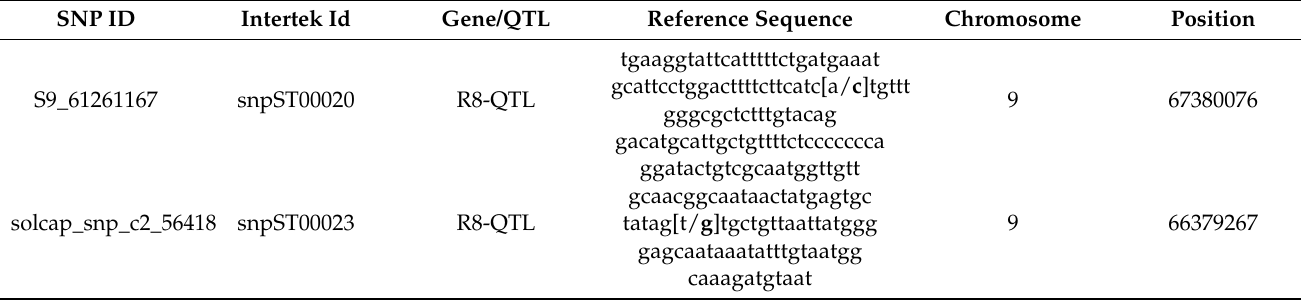
Table 1. List of KASP markers validated for late blight R8-QTL and PVY Ryadg resistance, the allele variants, and their position in the DM_v6.1 potato genome assembly are indicated. Alleles in bold denote the favorable allele that confers